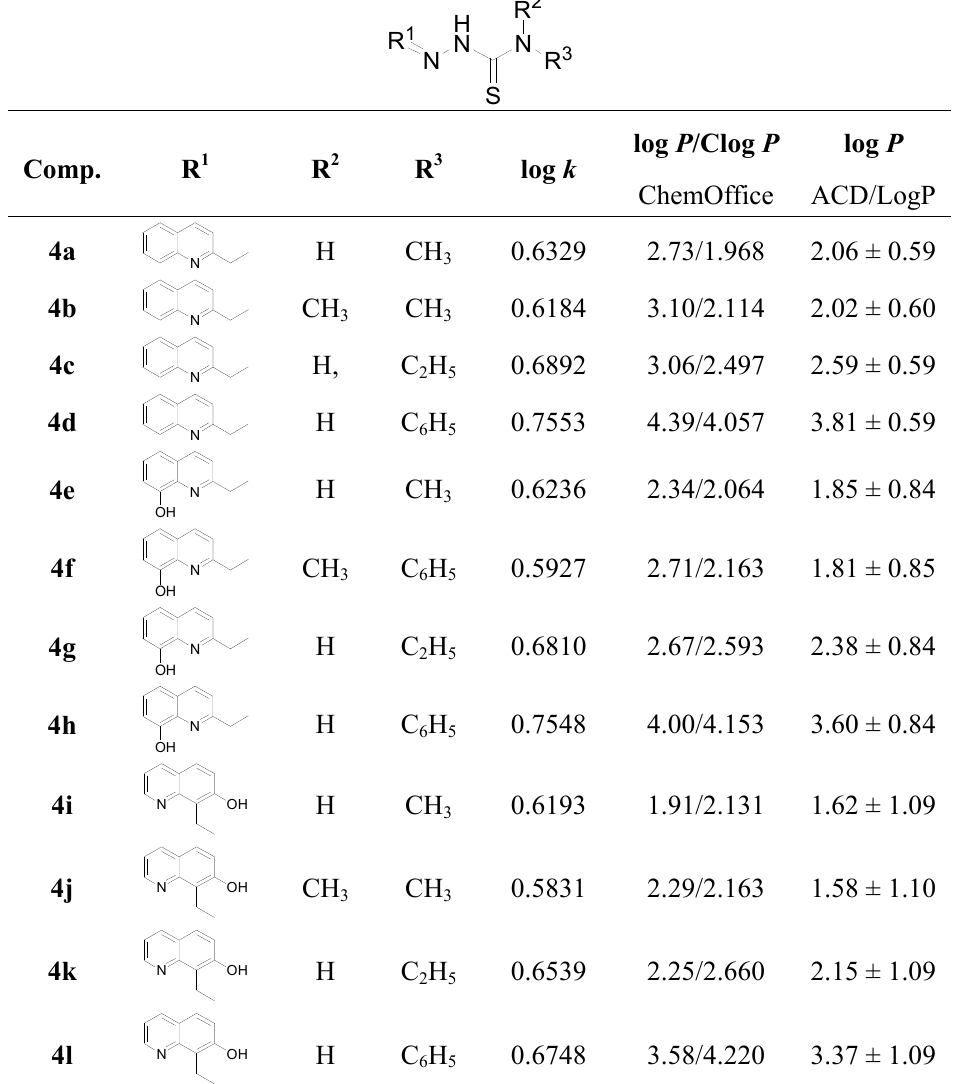
Table 2. Structure of heteroaryl compounds 4a – l and comparison of calculated lipophilicities (log P /Clog P ) with determined log k values. Comp. R 1 R 2 R 3 log k